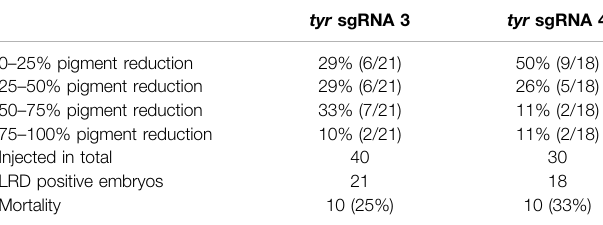
TABLE 2 | Summary of observed phenotypes of Δ tyr sterlet